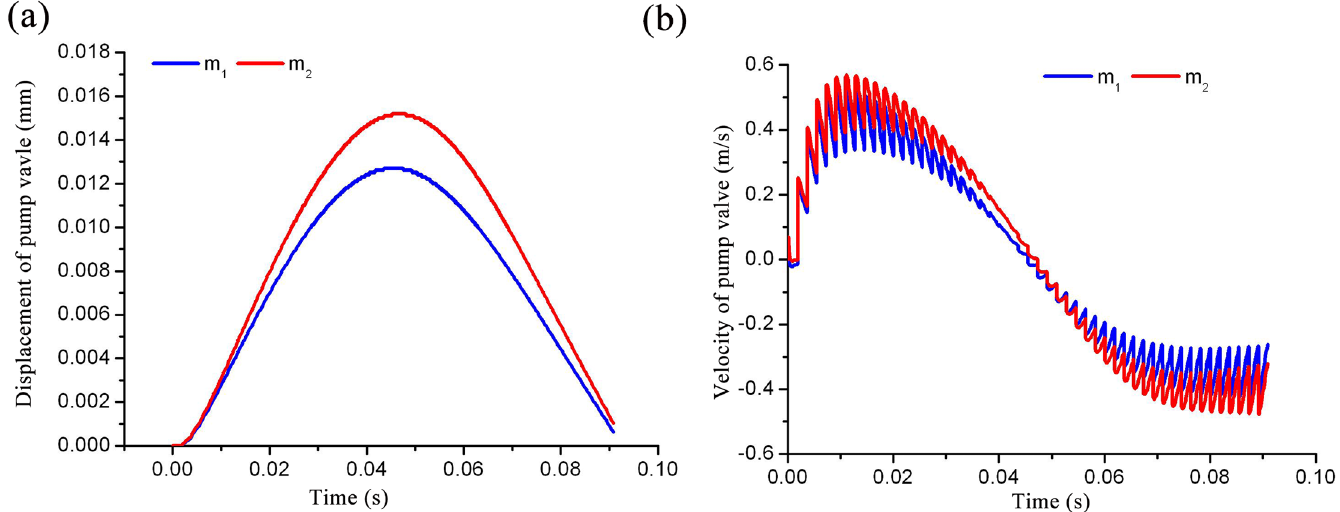
Fig 12. Curve of valve motion as a function of time with different valve masses. a) Displacement curve comparison; (b) velocity curve